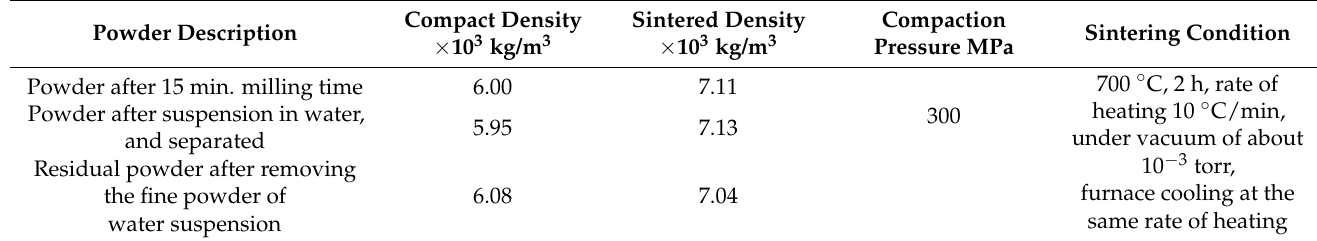
Table 5. Full description of compaction and sintering process of the used galena ore.